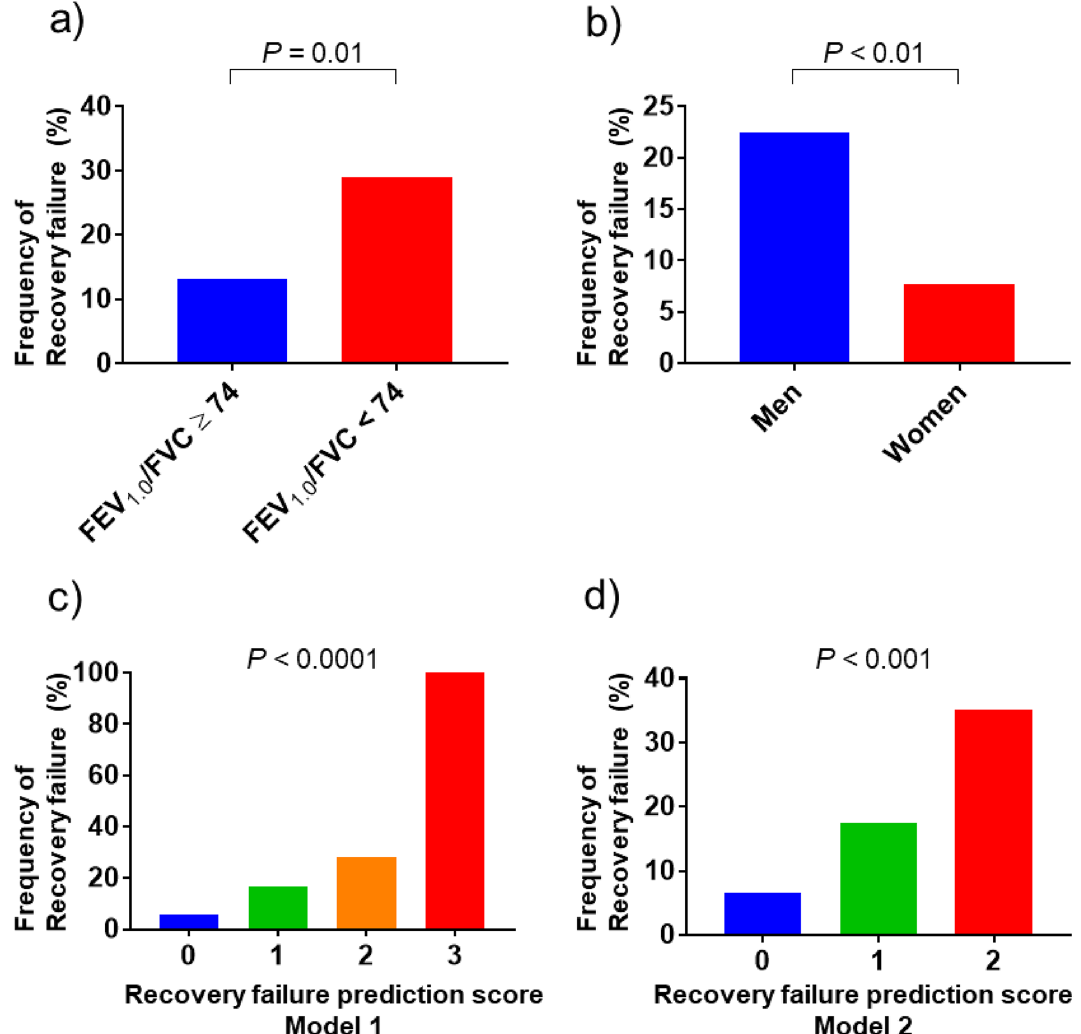
Figure 4. Predictive factors and recovery failure frequency in the validation cohort. ( a ) The recovery failure frequency is significantly higher in patients with an FEV 1.0 /FVC < 74% than in those with an FEV 1.0 /FVC ≥ 74% (28.9% vs. 13.2%, P = 0.01). ( b ) The recovery failure frequency is significantly higher in men than in women (22.4% vs. 7.7%, P < 0.01). ( c ) In model 1, each predictor (i.e., being a man, FEV 1.0 /FVC < 74%, BAL target site other than the RM/ LL) was assigned one point. The recovery failure frequencies in the prediction score groups (total scores 0, 1, 2, and 3) are 5.6%, 16.5%, 28.0%, and 100%, respectively ( P < 0.0001; c-index 0.69). (d) In model 2, each predictor (i.e., being a man and FEV 1.0 /FVC < 74%) was assigned one point. The recovery failure frequencies in the prediction score groups (total scores 0, 1, and 2) are 6.6%, 17.4%, and 35.1%, respectively ( P < 0.001; c-index 0.67). FEV 1.0 , forced expiratory volume in one second; FVC, forced vital